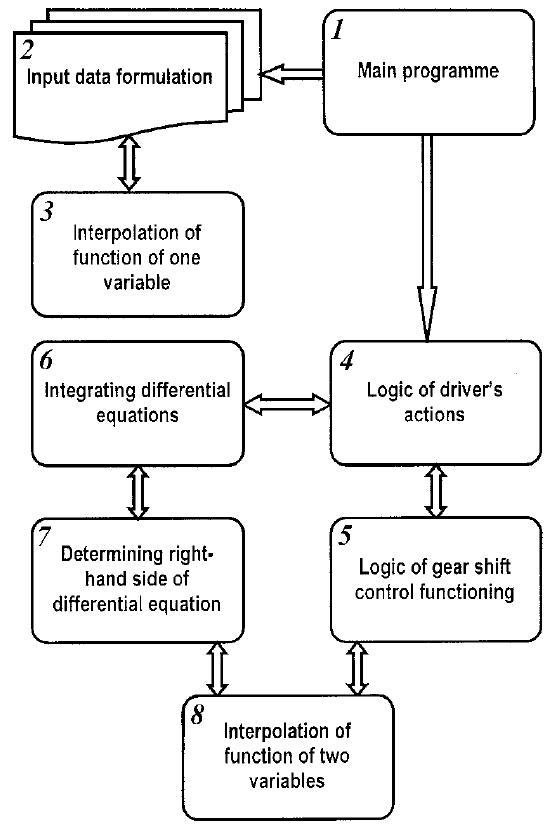
Figure 4: Structure of relations among algorithms of “driver- automation-vehicle-road” system modelling [own